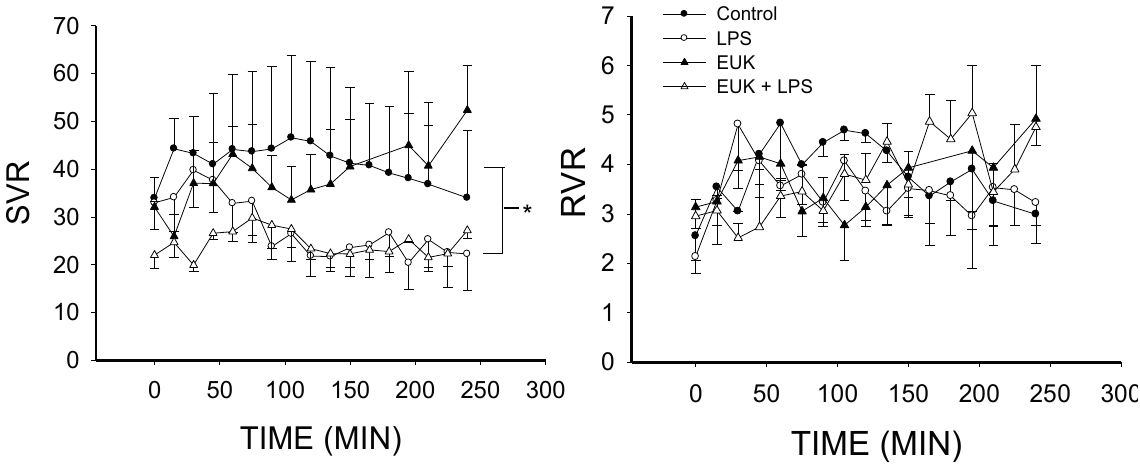
Figure 4. Systemic vascular resistance (SVR) and resistance to venous return (RVR) over time for the four conditions (mean ± SEM). Left , SVR fell in both LPS and LPS plus EUK-134 groups ( p < 0.001). There were no differences between LPS and LPS plus EUK-134 nor between Control and EUK alone; Right , RVR was not different among the four groups. * p <